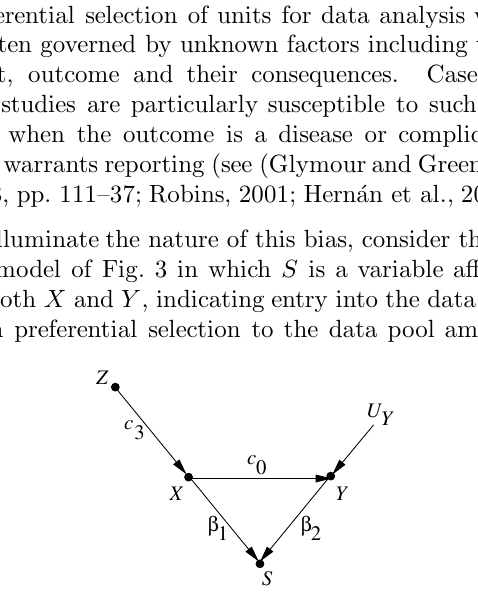
Figure 3: A model illustrating selection bias; condi- tioning on S induces spurious associations between X and Y